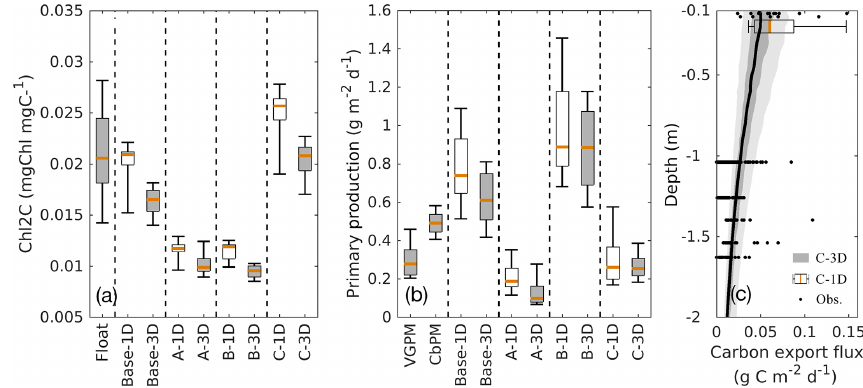
Figure 10. Comparisons of the chlorophyll-to-carbon ratio (a) , primary production (b) , and carbon export fluxes (c) between the 1D and 3D